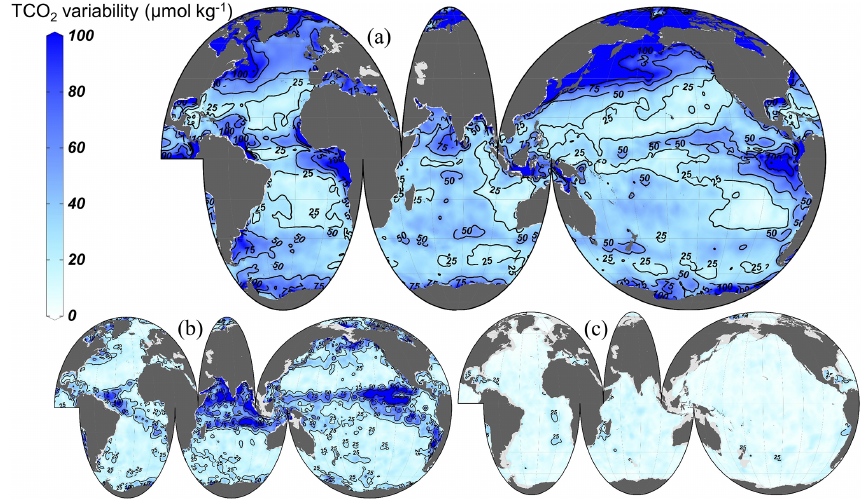
Figure 8. Seasonal amplitude of TCO 2 at (a) 0m, (b) 100m, and (c) 1500m. The contour lines of 25, 50, 75, and 100µmolkg − 1 are shown. This figure was made with Ocean Data View (Schlitzer,